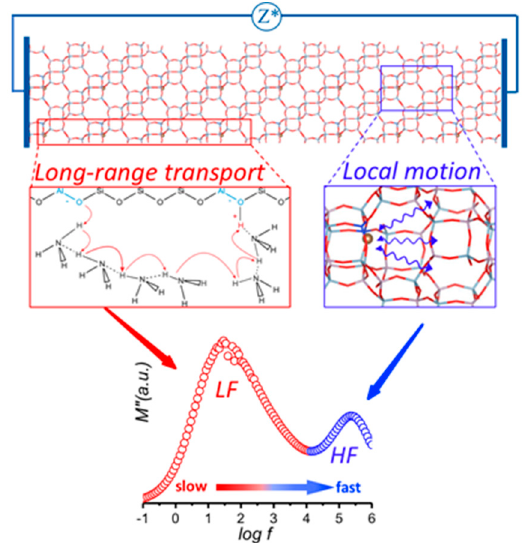
Figure 9. Schematic representation of impedance-based in situ modulus spectroscopy for monitoring the long- and short-range motion of cations within Cu-zeolite catalysts: reproduced with permission from [110], copyright The Royal Society of Chemistry, 2019.